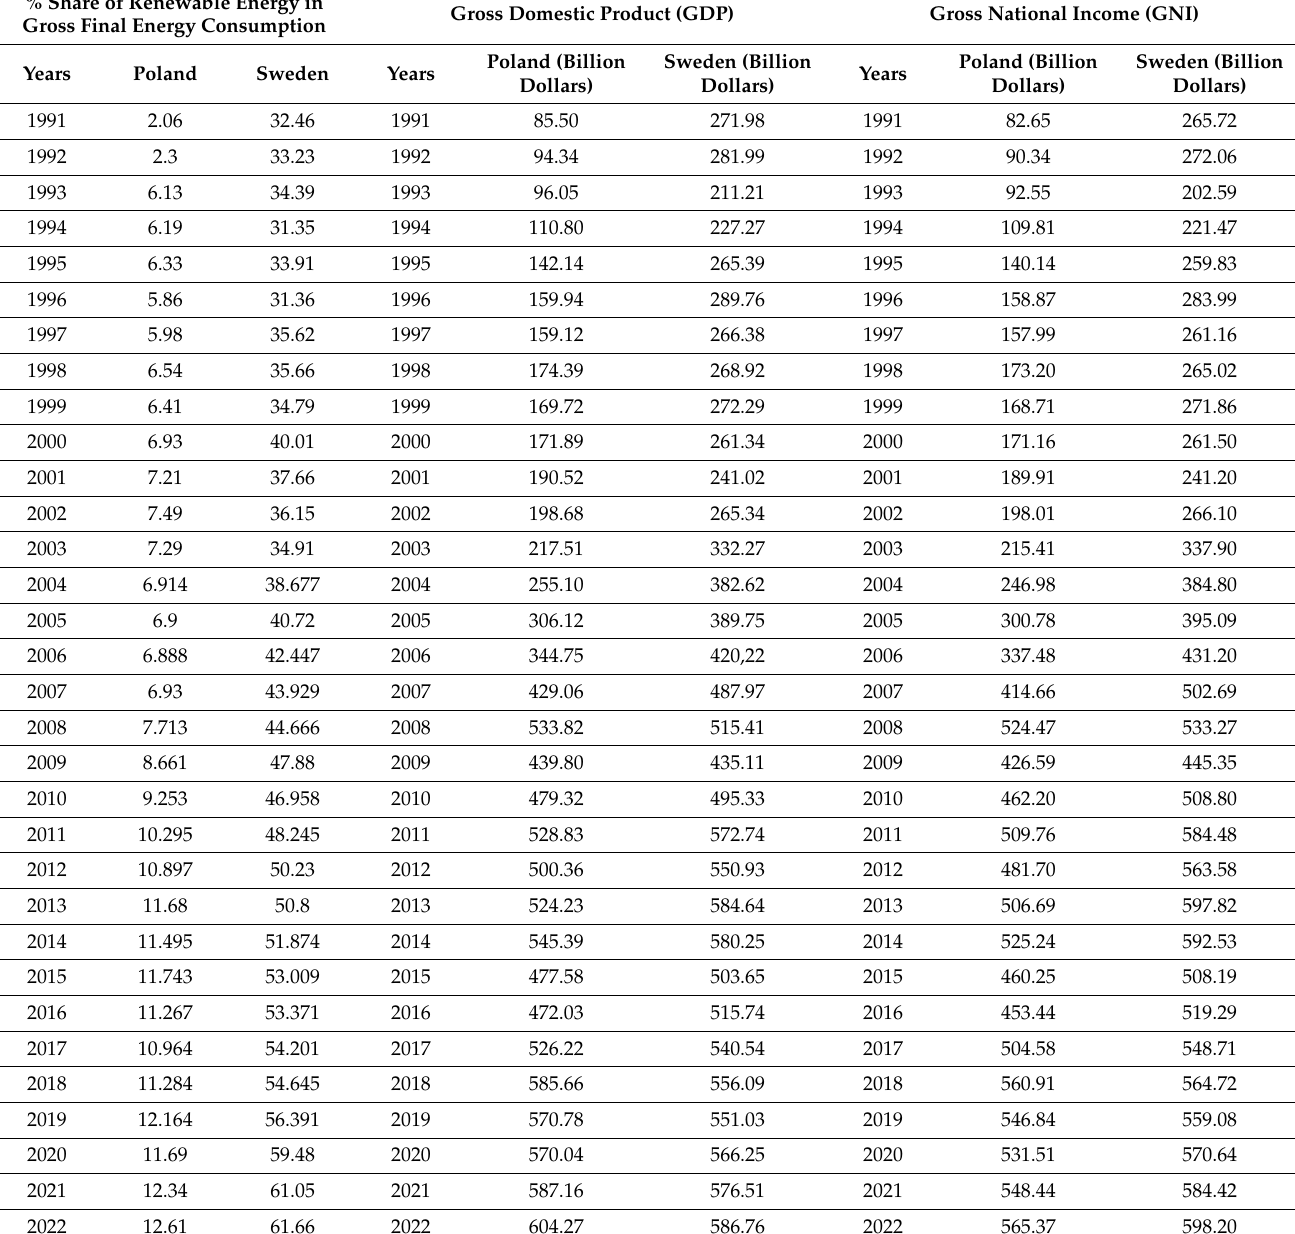
Table 1. Coefficients of the Gross Domestic Product (GDP), Gross National Income (GNI), and renewable energy resources (RES) share in the final use of gross